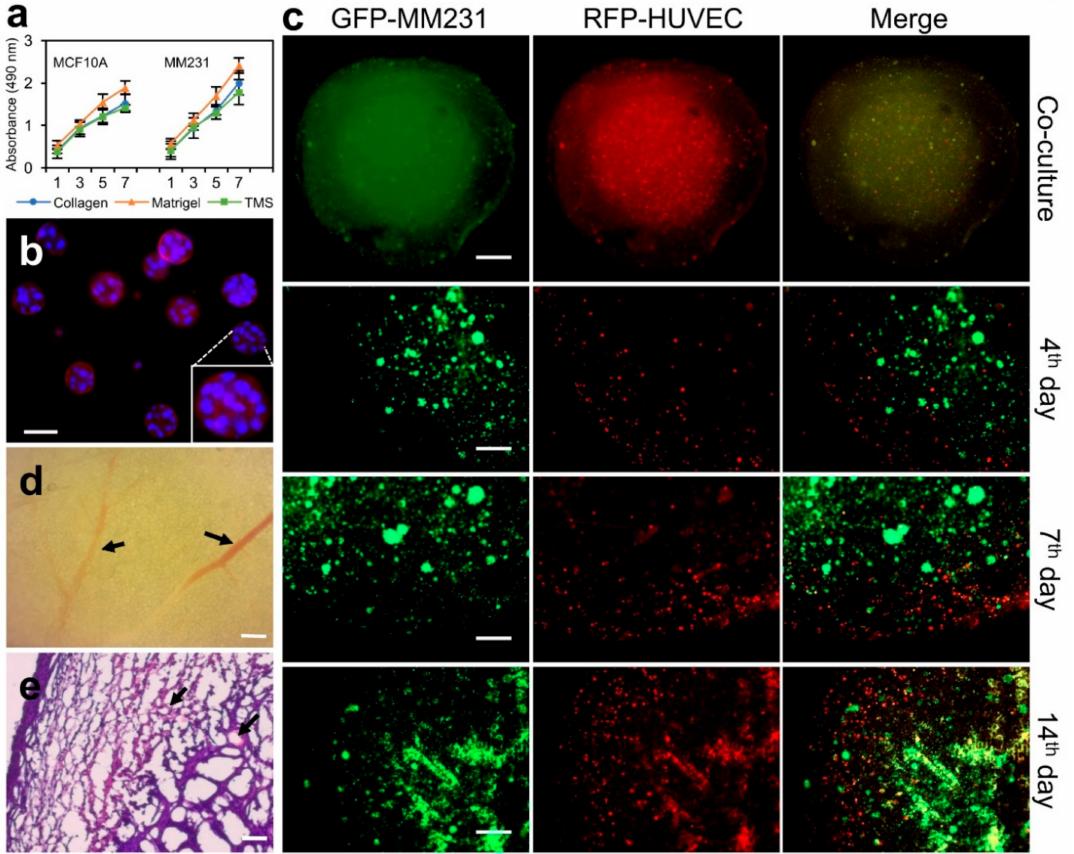
Figure 4. Applications of porcine breast ECM hydrogel and porous scaffolds in proliferation, migration, and tumor formation experiments. ( a ) Proliferation of MCF10A or MM231 cells on the porcine breast ECM hydrogel. Error bars, mean ± SD. ( b ) MCF10A cell acini formation within the ECM hydrogel. ( c ) Compartmental culture of MM231 cells and HUVECs to assess cross-compartmental migration of different types of cells. ( d ) The vasculature of a whole mount cross section of breast tumors from mice MFP implanted with MM231 cell-laden porous TMS derived from the porcine ECM hydrogel. ( e ) H&E staining of the cross sections of mice breast tumors developed from the cancer cell-laden TMS. Black arrows in d and e indicate blood vessels. Scale bars, 50 µ m for ( b ); 1 mm—upper first panel ( c ) & 500 µ m—lower three panels ( c ); 200 µ m for ( d , e